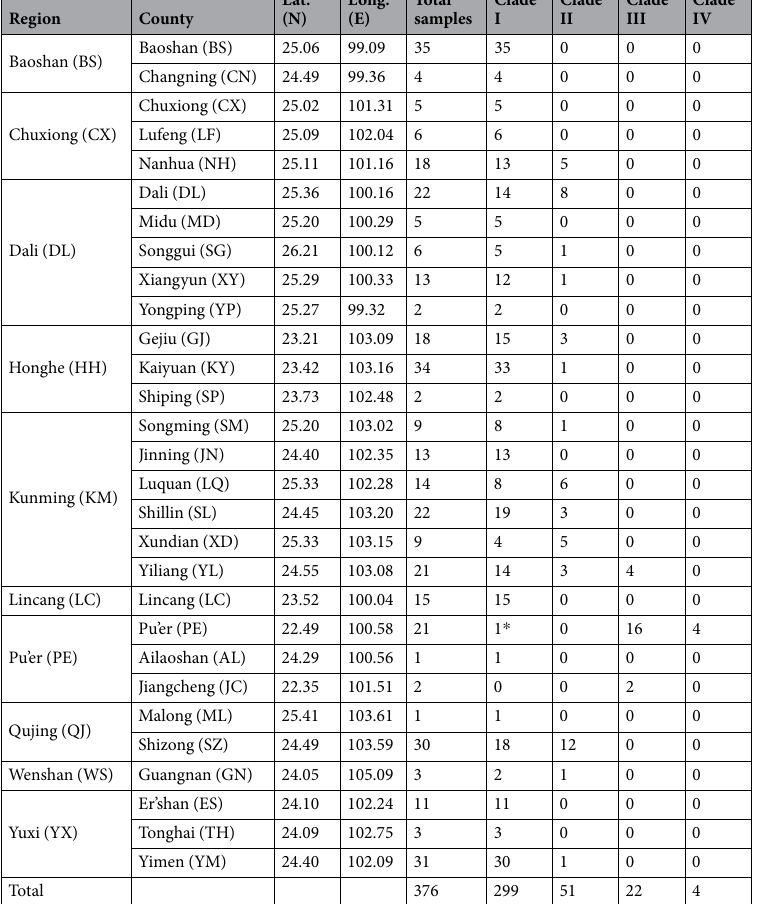
Table 1. Geographic locations and phylogenetic distributions of the obtained specimens used in this study. Clades I-IV refer to the number of isolates corresponding to the clades identified previously by Sha et al . 17 based on ITS sequences. The sample with asterisk represents the type specimen of Th. ganbajun